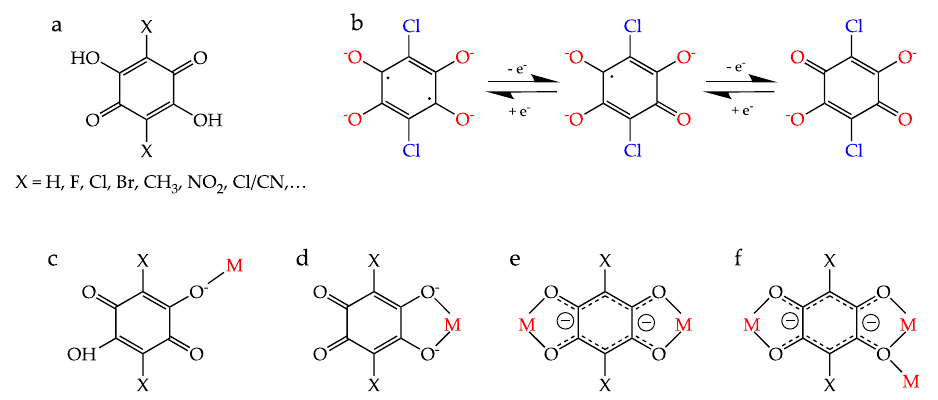
Scheme 1. ( a ) The 3,6 ‐ disubstituted anilato derivatives (H 2 C 6 O 4 X 2 ). ( b ) Reduced forms of the